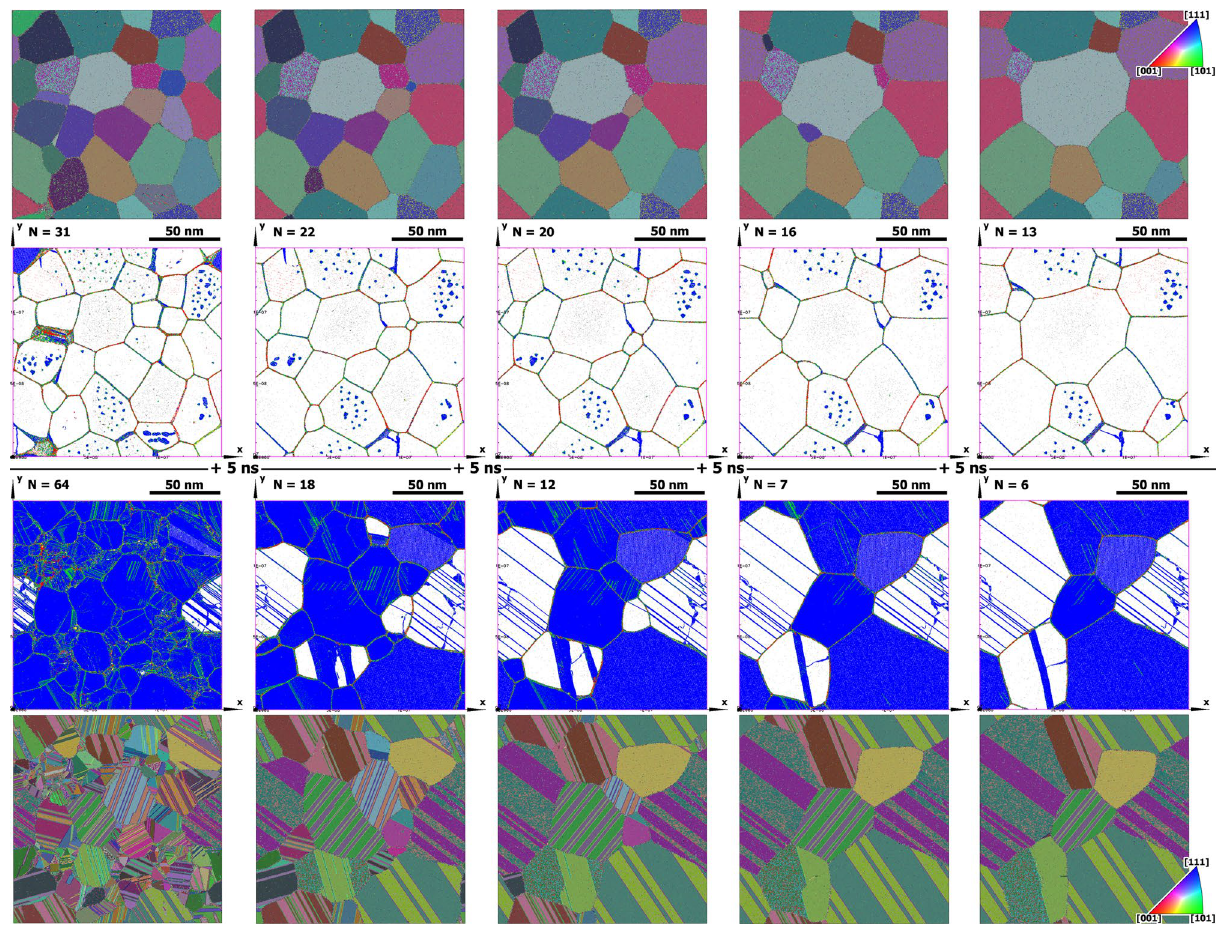
Figure 3. Comparison of the nanocrystalline grains and ingrain defect structures of V-type and M-type samples during annealing at T = 0.904 T m . The first two rows are for the V-type sample while the last ones are for the M-type sample. The orientation colouring was done using PTM analysis in OVITO visualization software. The defect structure recognition was done by the ATA. The snapshots from left to right are separated by 5 ns time intervals. N is the number of grains in the samples at the presented